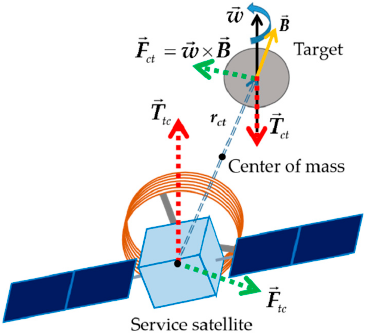
Figure 1. Schematic diagram of conventional mode.